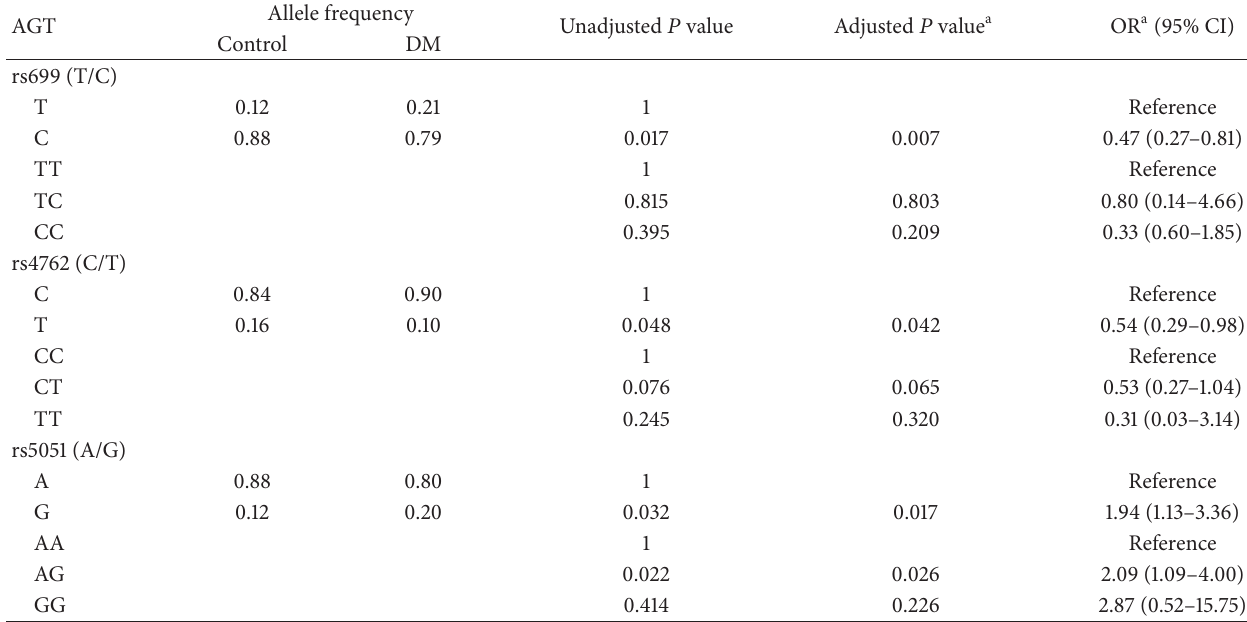
Table 3: Association of AGT SNPs with diabetes in the male gender.